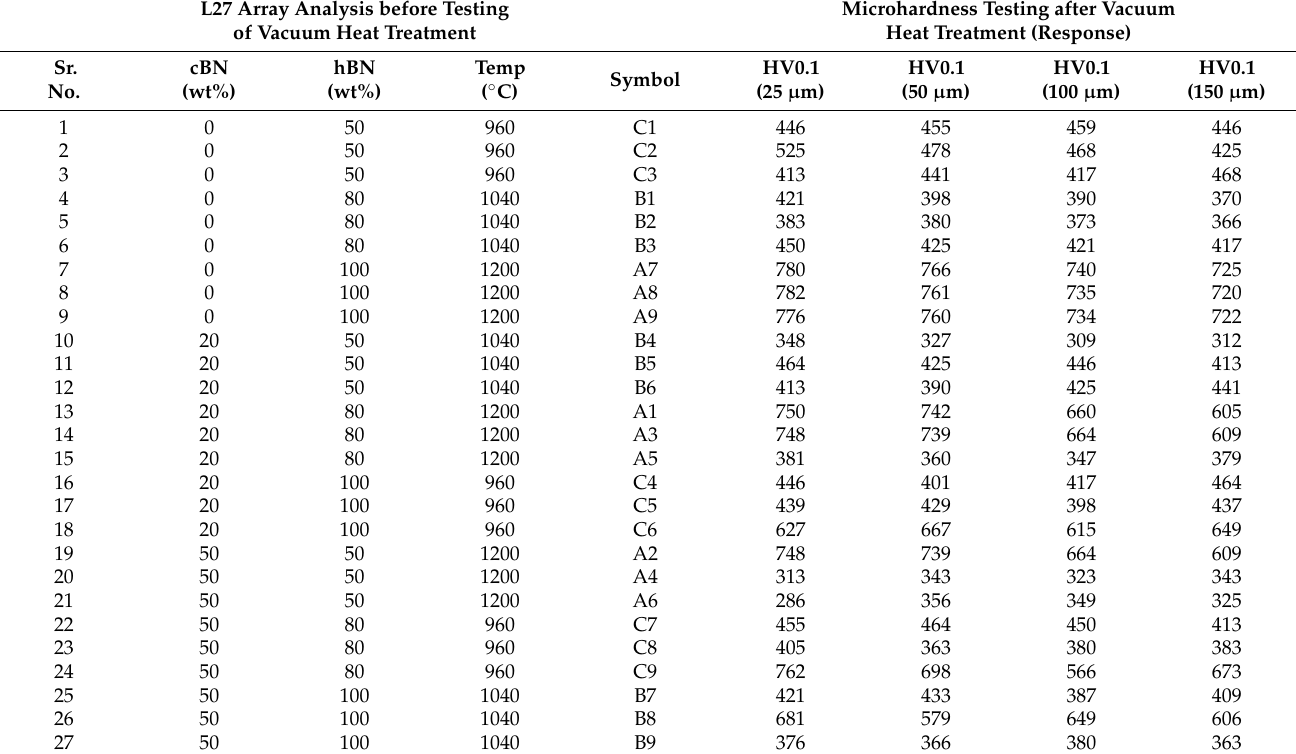
Table 5. Experimental design matrix using L27 orthogonal array with response test